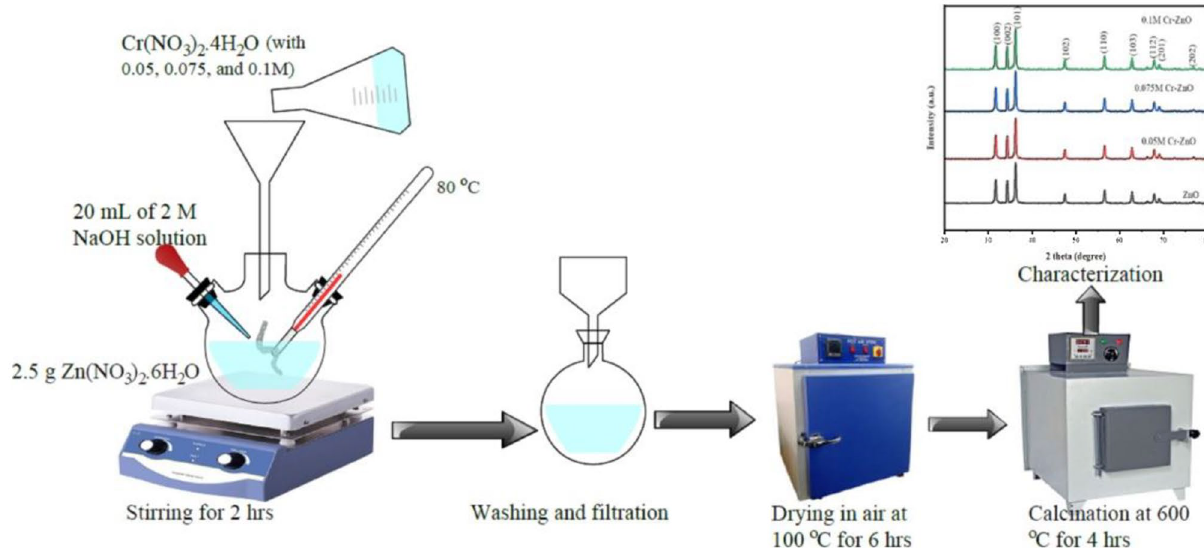
Fig. 1 Schematic illustration of Cr-doped ZnO nanoparticles synthesis by chemical co-precipitation